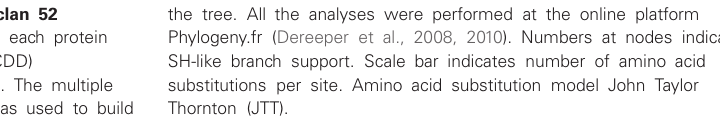
FIGURE 5 | Maximum likelihood phylogenetic tree of clan 52 cytochrome P450s. The putative conserved domains for each protein were picked up from the conserved domain database (CDD) (Marchler-Bauer et al., 2011), and aligned using MUSCLE. The multiple sequence alignment was cured with Gblocks. PhylML was used to build